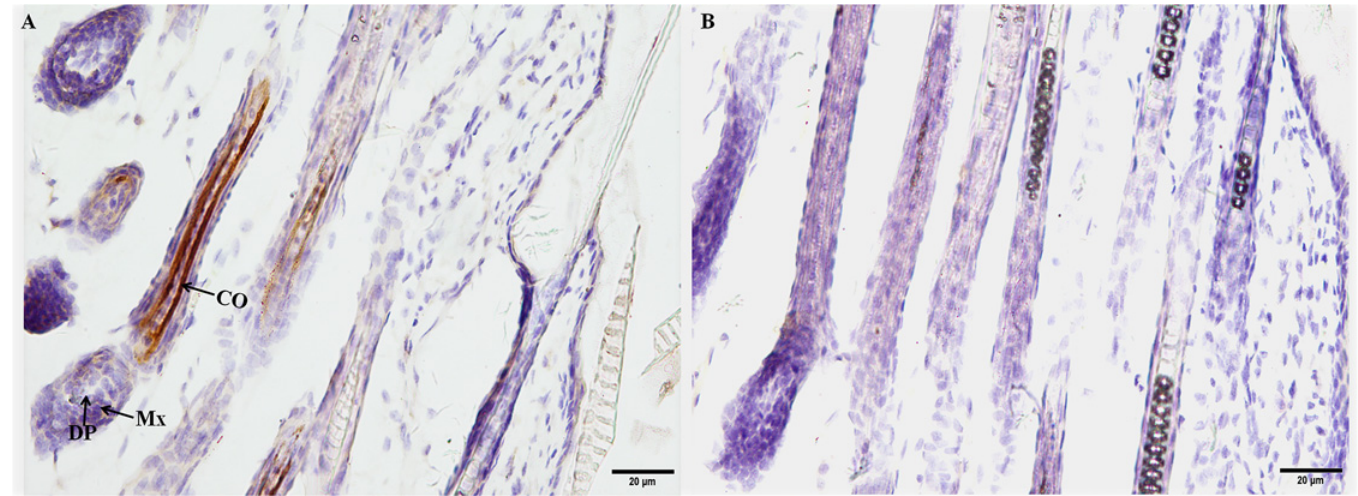
Fig 8. Immunohistochemical analysis of ZsGreen1 in dorsal hair from the KRTAP11-1-ZsGreen1 transgenic mouse. (A) Images of the hair follicles of the positive transgenic mouse were collected during the anagen phase (P14). A strong positive signal of ZsGreen1 was observed in the cortex of the hair follicle. No signal was detected in other cells of the hair and skin. (B) Negative control. Co: cortex; DP: dermal papilla; Mx: matrix. Scale bars = 20 μ m (A, B).